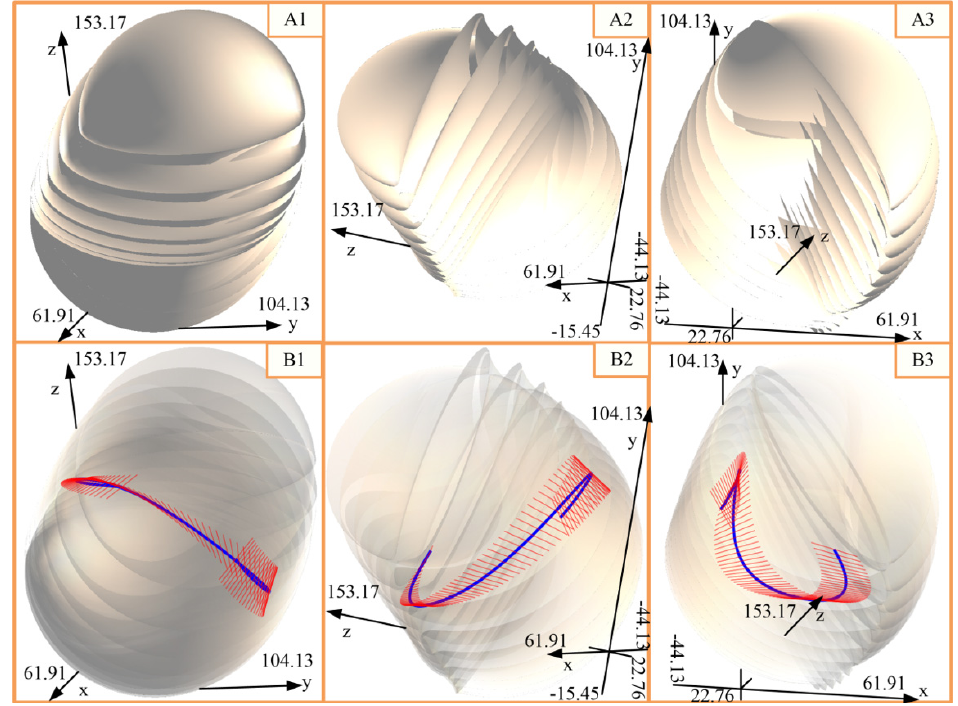
Figure 15. The striction curve of an axode and the densest distribution zones.